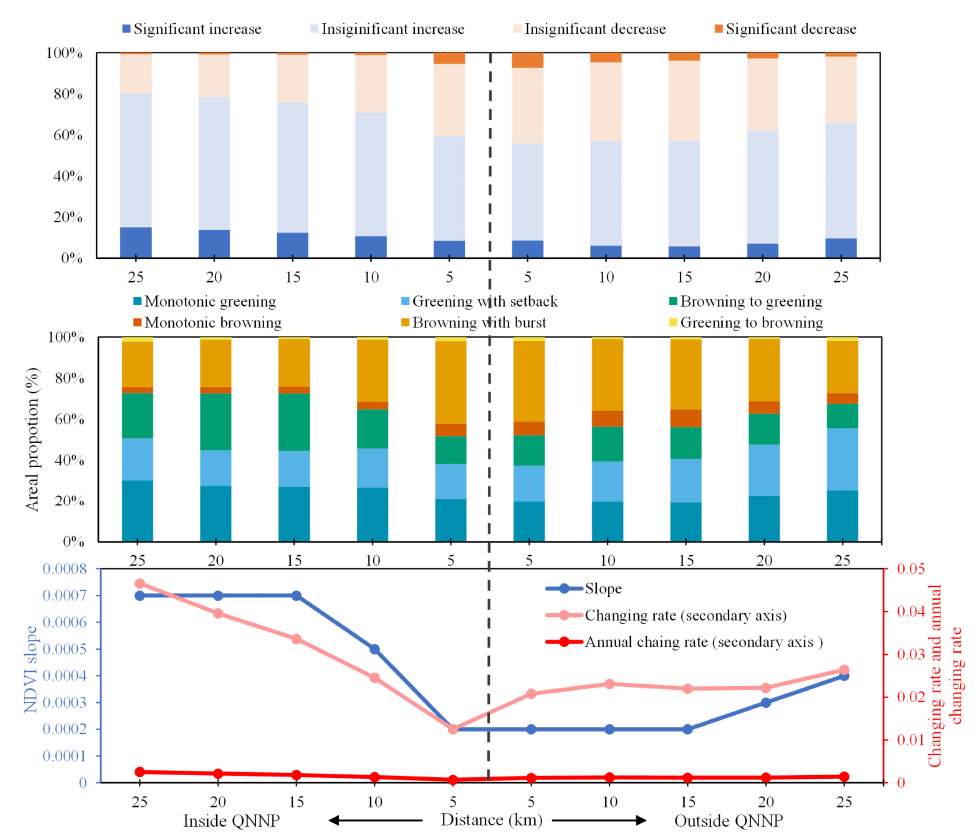
Figure 10. Spatial distribution of trends of NDVI near the boundary. The X-axes indicate the distance from the reserve boundaries. Figure on the left side of the dotted line exhibits vegetation change inside the reserve, while figure on the right side of the dotted line indicates the vegetation conditions outside the